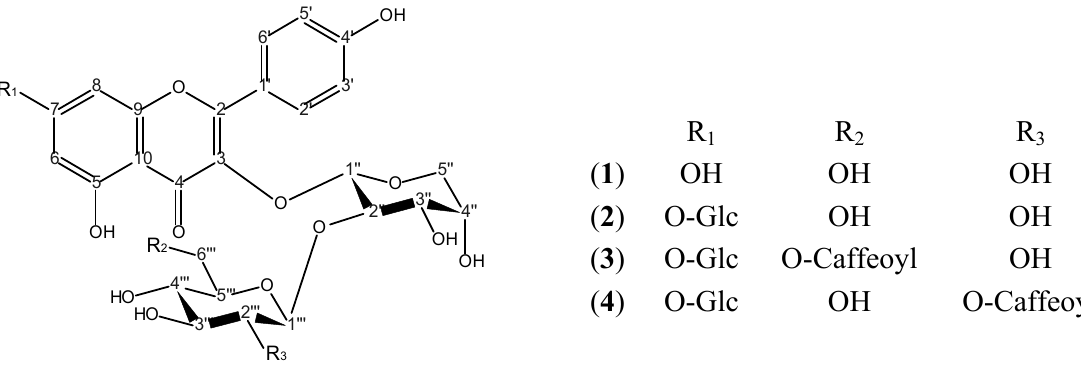
Figure 1. Chemical structures of compounds 1 – 4 isolated from the leaves of Brugmansia suaveolens